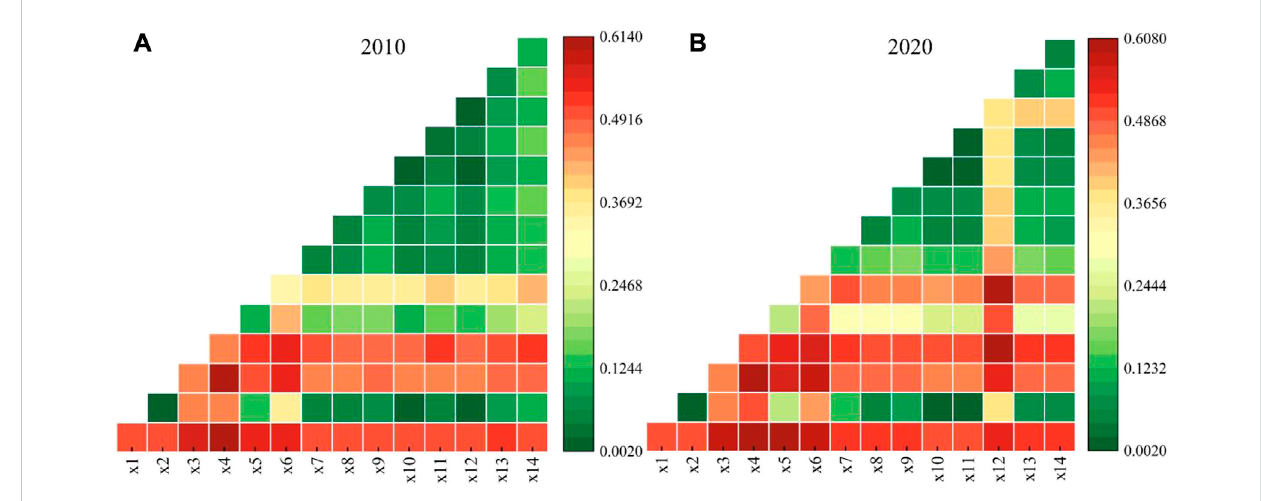
FIGURE 14 Results of interaction detection of factors in fl uencing habitat quality in Anhui Province in 2010 (A) and 2020 (B)